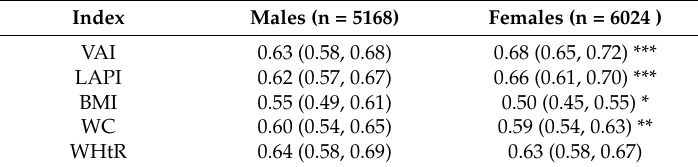
Table 4. The area under the curve of each anthropometric measure for the presence of CKD in both both genders. genders.